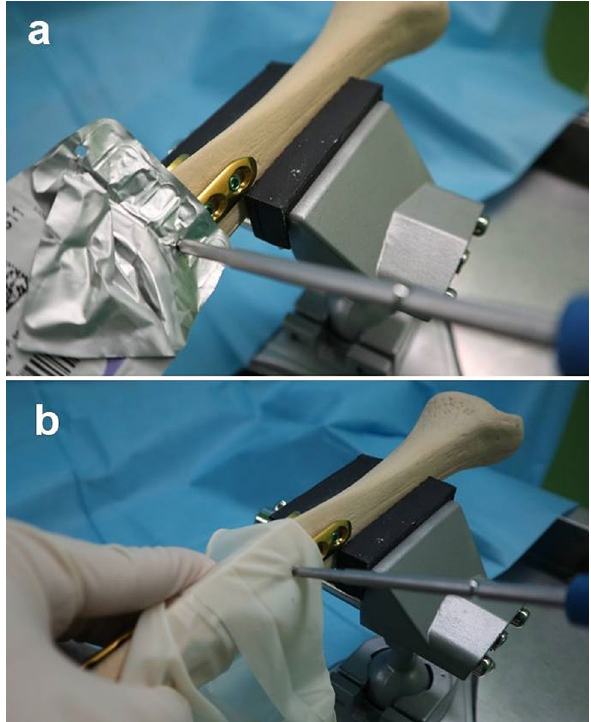
Figure 3. ( a ) Twenty screws were removed with the foil from a suture packet inserted into the screw socket using the straight-handle driver. ( b ) Twenty screws were removed with the parts of a latex glove inserted into the screw socket.